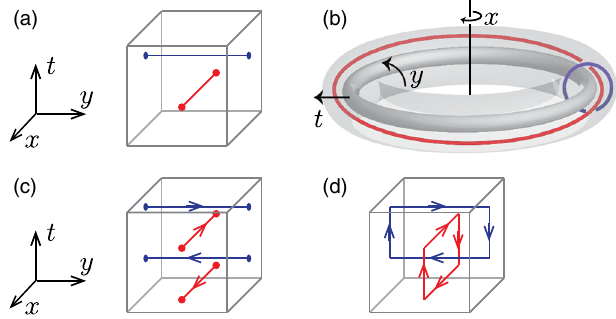
FIG. 2. An S -matrix element and braiding in ð 2 þ 1 Þ D. (a) Matrix element equals an overlap of two MESs, shown as a time sequence. Any MES is defined by action of particle tunneling operator along x on the appropriate reference state defined by x direction. The MES at later time (blue) has been acted on by S modular transformation, so the tunneling is along y , and the final reference state is defined by y direction. (b) Embed- ding the spacetime process of (a) in three dimensions shows that the two worldlines are linked. Time grows in the radial direction as shown, so the spacetime of (a) spans the volume of a toroidal slab. (c) Alternatively, the matrix element equals a product of tunneling operators, also presented as a time sequence. Arrows mark the action of tunneling operator and its inverse. Because of taking the expectation value of this operator product, the initial and final state are the same, in contrast to (a). (d) Connecting the worldlines from (c), one obtains two worldlines that are